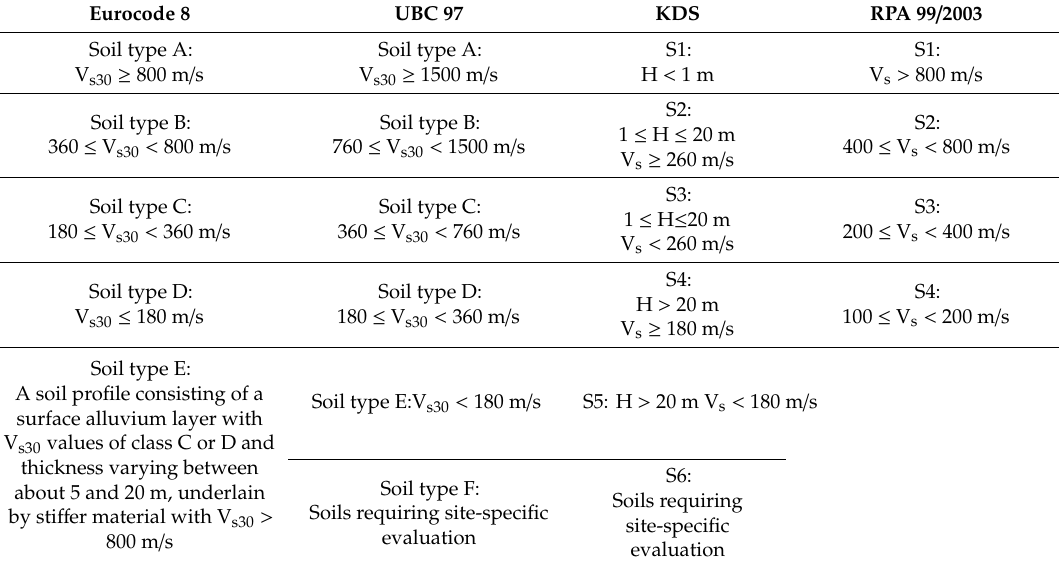
Table 3. Soil types specified in EC 8 (Eurocode 8), UBC 97 (Uniform Building Code), KDS (Korean Design Standard), and RPA 99 / 2003 (Regles Parasismiques